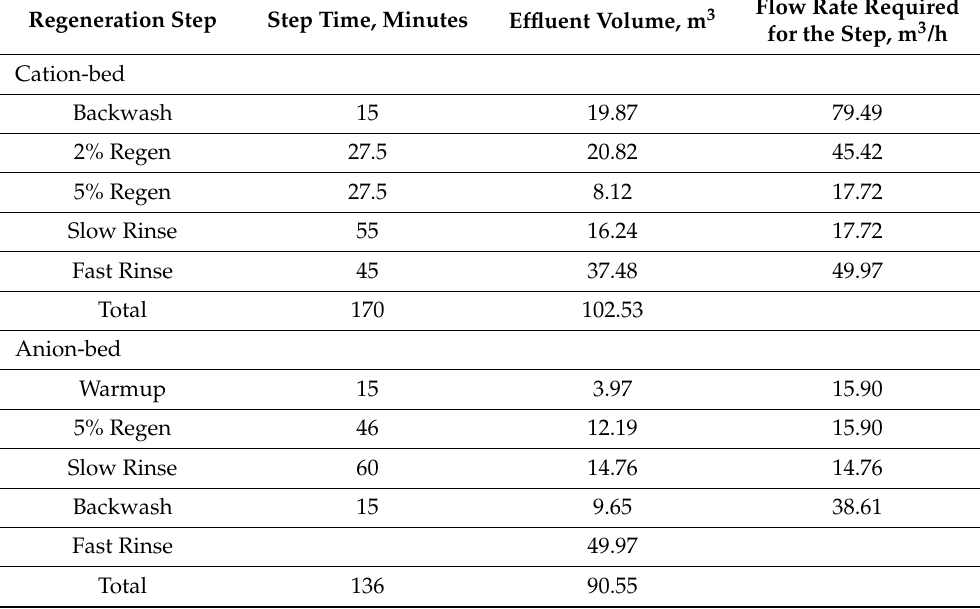
Table 1. Cation and anion bed regeneration step